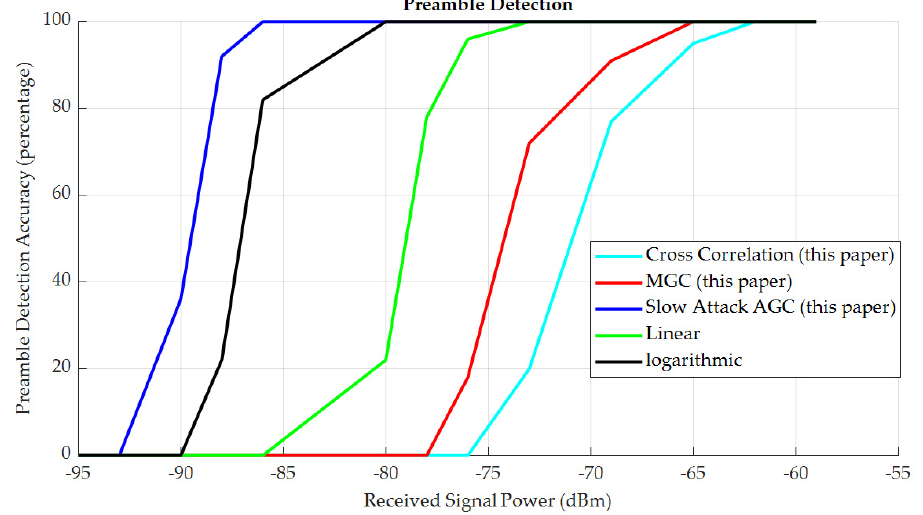
Figure 10. Preamble detection accuracy for various approaches.